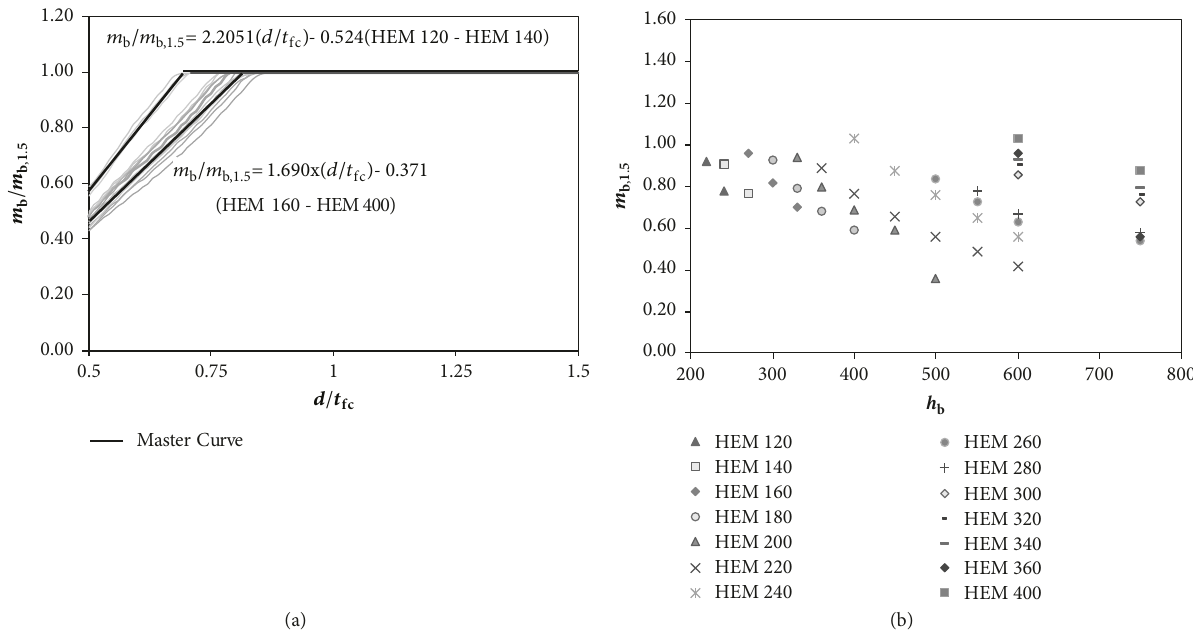
depending on the column section size. Equation (5) can be used to estimate 𝑚 b in case of beam-to-column joints having HEM 120 or HEM 140 column cross section.